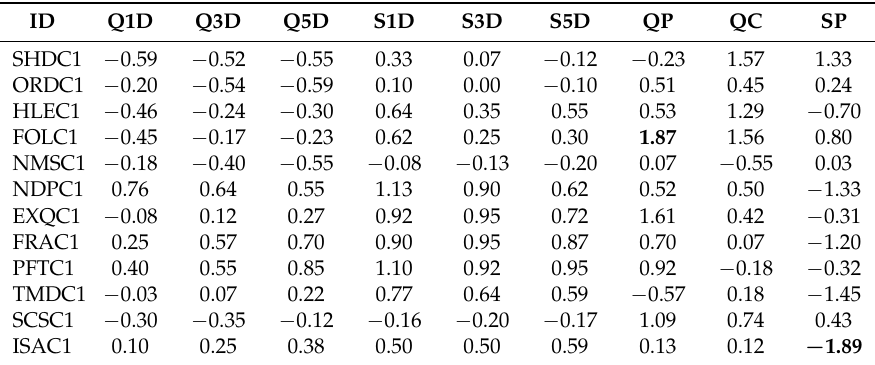
Table 6. z -Value of the MKT on runoff indices 1 .